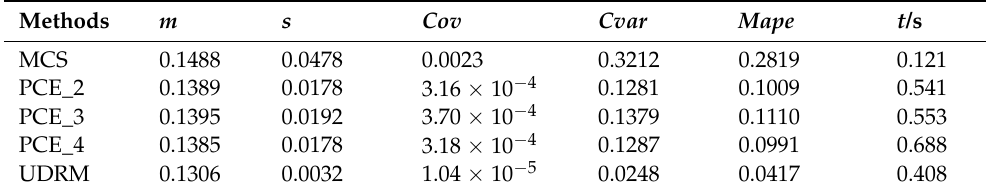
Table 5. Evaluation table of different UQ methods under 50% uncertainty of the cable length under normal operation.